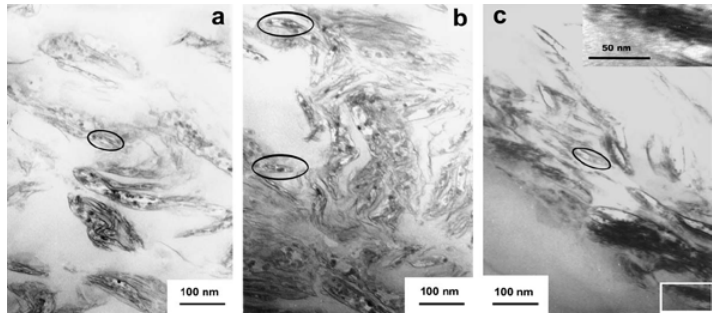
Figure 7. TEM of PS/LDH nanocomposites sample: (a) 5 wt %; (b) 10 wt %; (c) 20 wt %. The inset in (c) shows an enlarged image of the part marked by a rectangle (adapted from Ref. [63]).